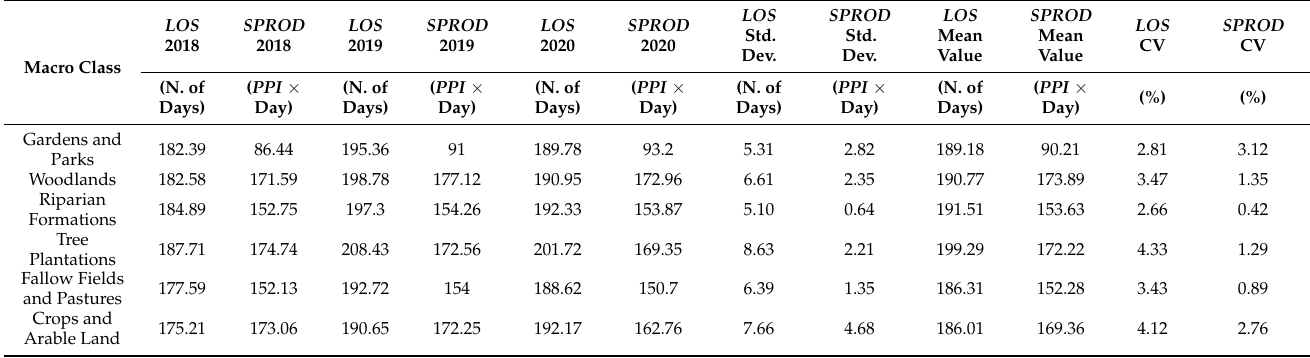
Table 4. Yearly mean values of LOS and SPROD at vegetation macro-class level. Mean and stan- dard deviation values are computed along time. CV is the correspondent coefficient of variation (std. dev./mean ×